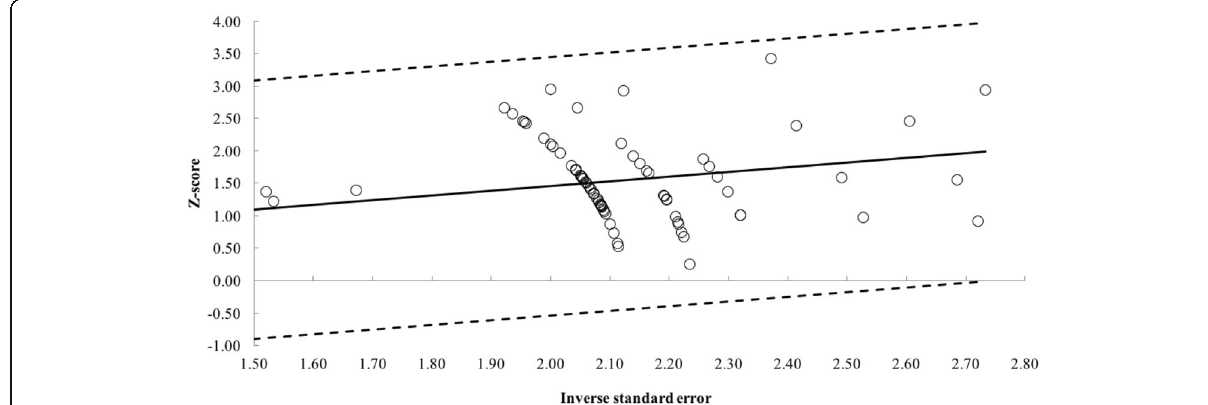
Fig. 3 Galbraith plot with the removal of seven pre- vs. post-intervention study outliers [20, 21, 23, 40 – 43]. Each open circle represents one pre- vs.-post-intervention study